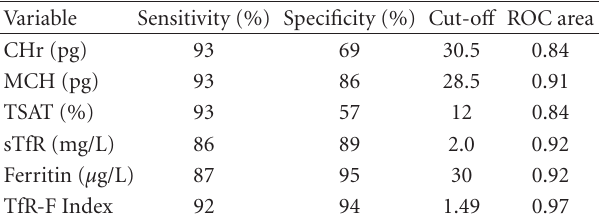
Table 2: Test characteristics based on optimal Cut-o ff Values for IDA Screening Determined by ROC Curve Analysis. Abbreviations: CHr, Reticulocyte Hemoglobin Content; MCH, Mean Corpuscular Hemoglobin; TSAT, Transferrin Saturation; sTfR, Soluble Transfer- rin Receptor; TfR-F Index, sTfR/log Ferritin; IDA, Iron Deficiency Anemia; ROC, Receiver Operation